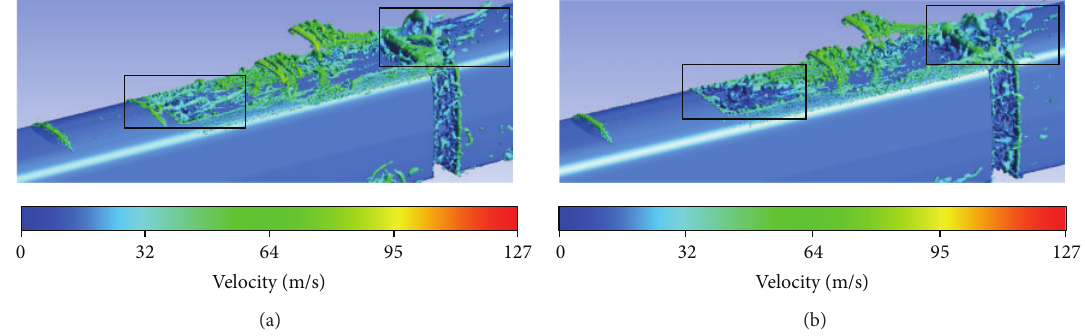
Figure 22: Isosurfaces of the instantaneous normalized Q-criterion for different pantograph fairing structures: (a) Dlz2 and (b) Dlz3.